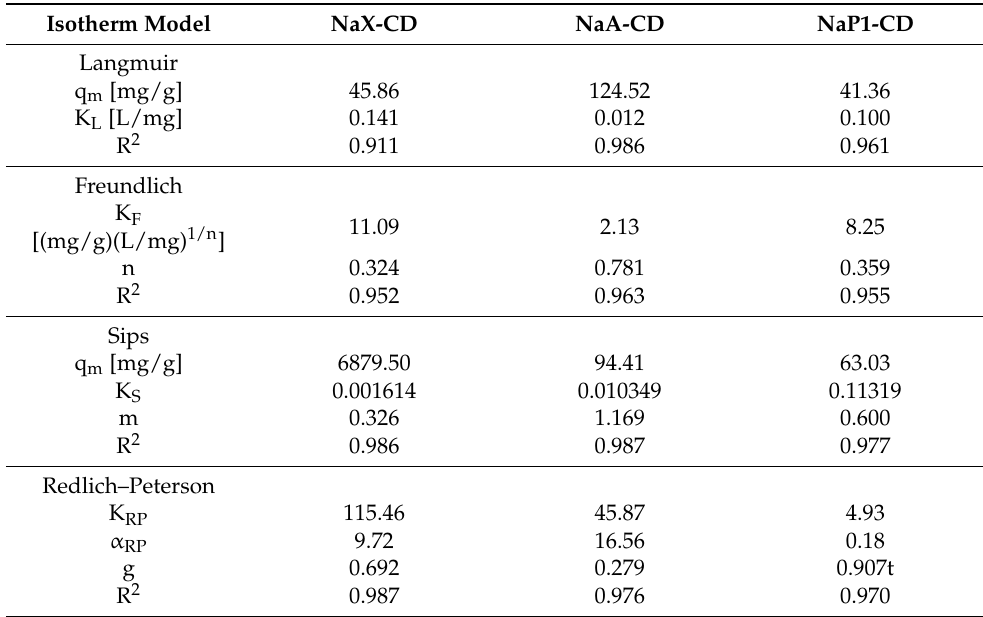
Table 6. Isotherm parameters for the adsorption of tetracycline on NaX-CD, NaA-CD and NaP1-CD. Isotherm Model